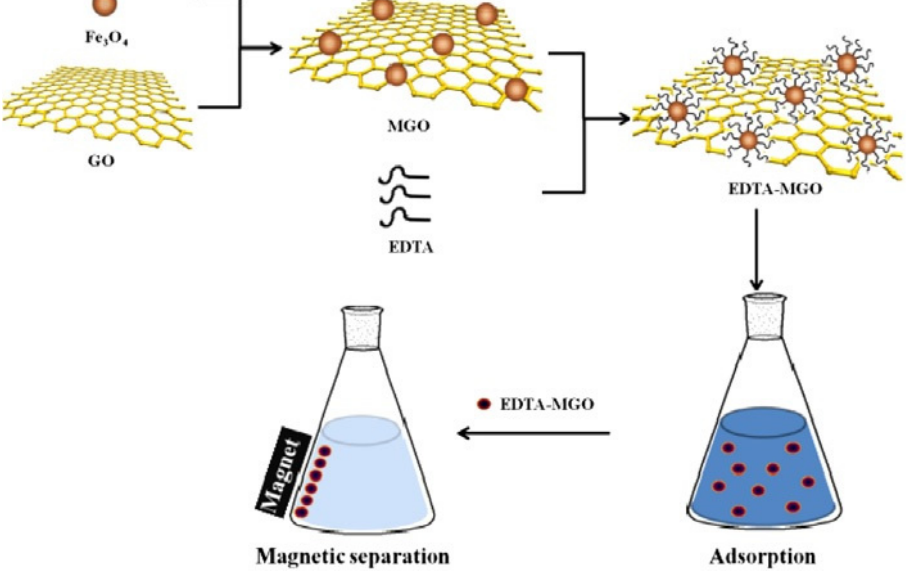
Figure 12. Adsorption and separation process of mercury on EDTA-MGO (Reproduced or adapted from ref. [76] , with permission from Elsevier, 2020).